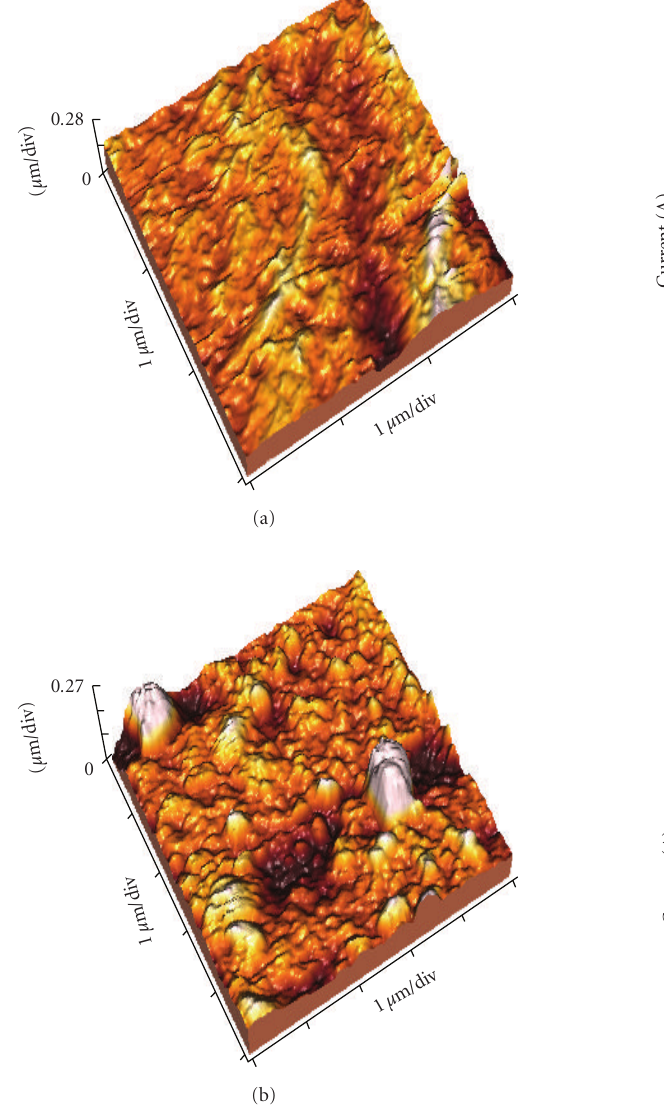
Figure 2: AFM image of (a) ppy/MWCNT/GCE and (b) oppy/ MWCNT/GCE.